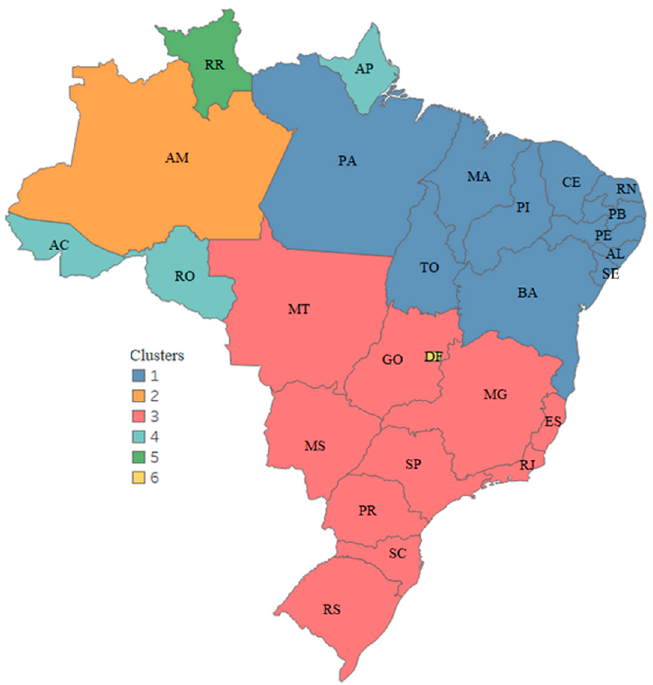
Figure 8. Clustering of Brazil—Infodemic × president of the republic. States assigned to the same cluster share the same color.